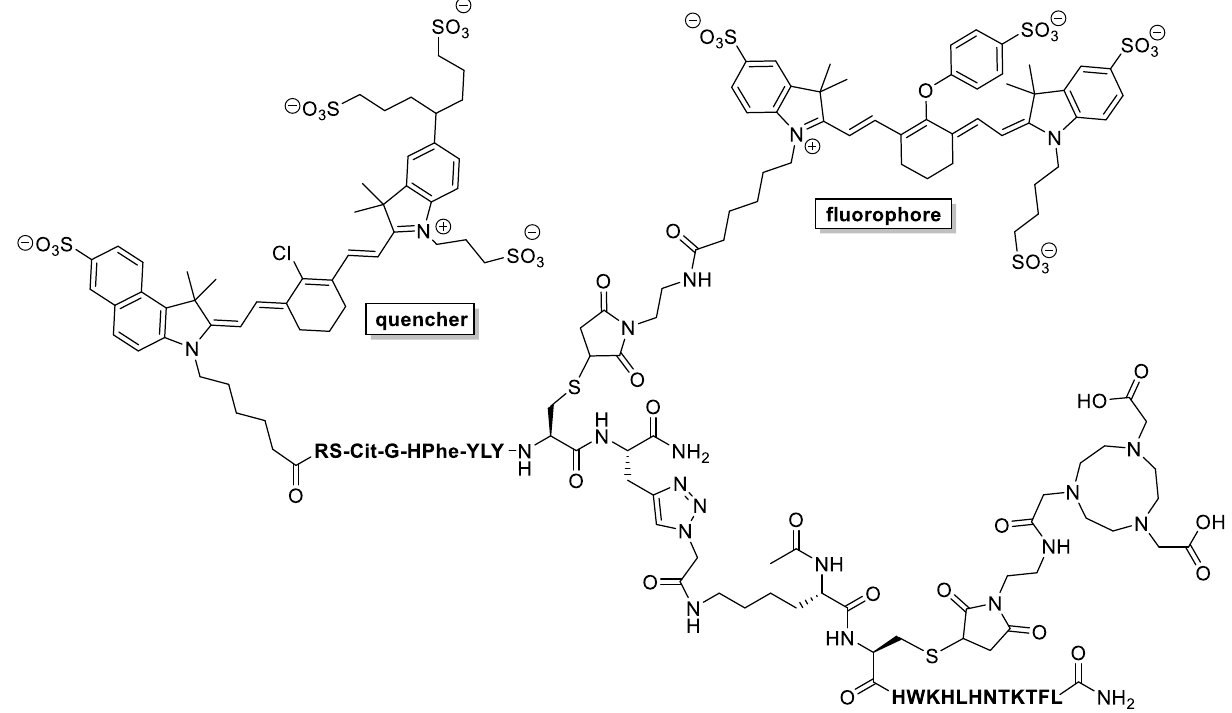
Figure 4. Structure of metal-free dual-probe precursor 2 , which targets MMP-14 as a glioma tracer.